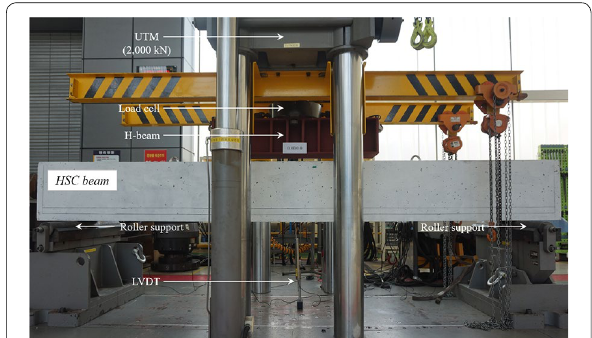
Fig. 4 Detail of the structural test